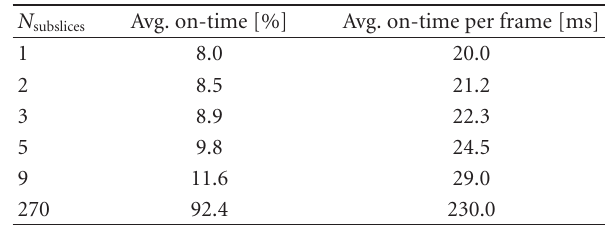
Table 1: Average